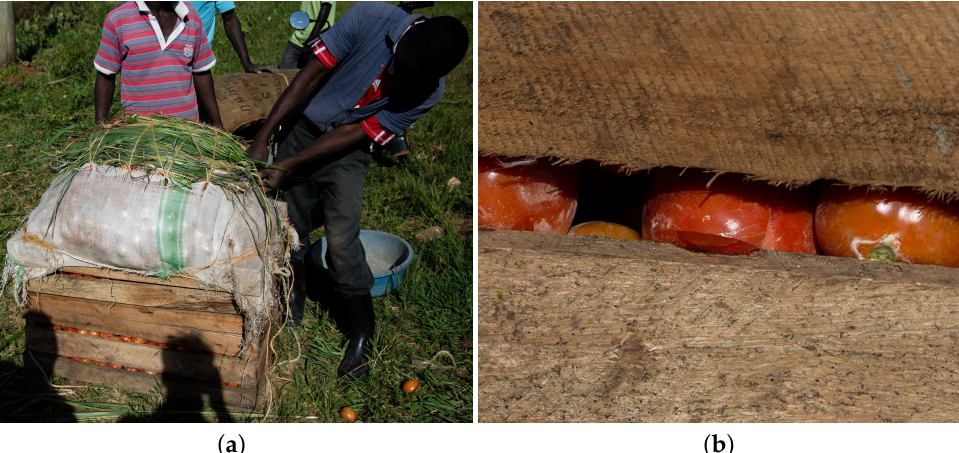
Figure 3. Tomato packaging in Uganda farm (©Julien Lépine). ( a ) Tomato packaging for transporta- tion. ( b ) Zoom in on mechanical damage that occurred during packing.